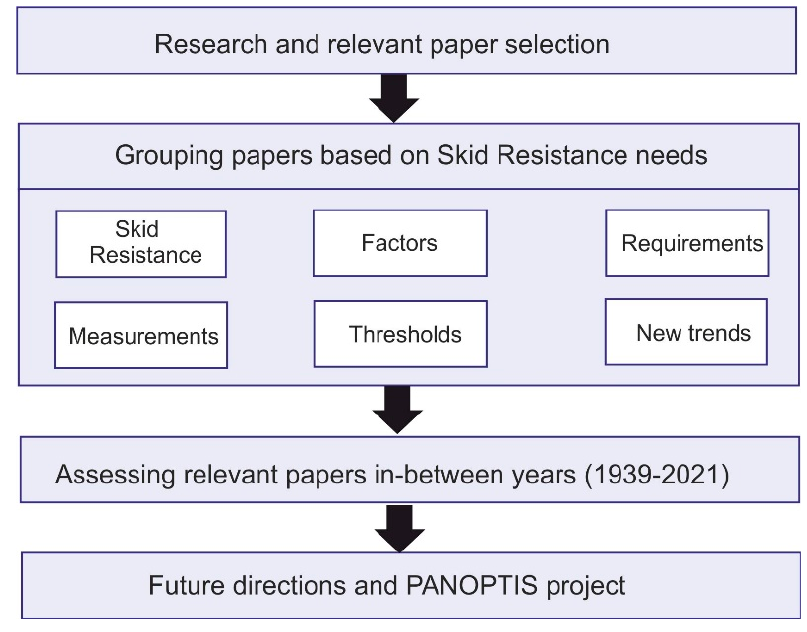
Figure 1. Review methodology framework.